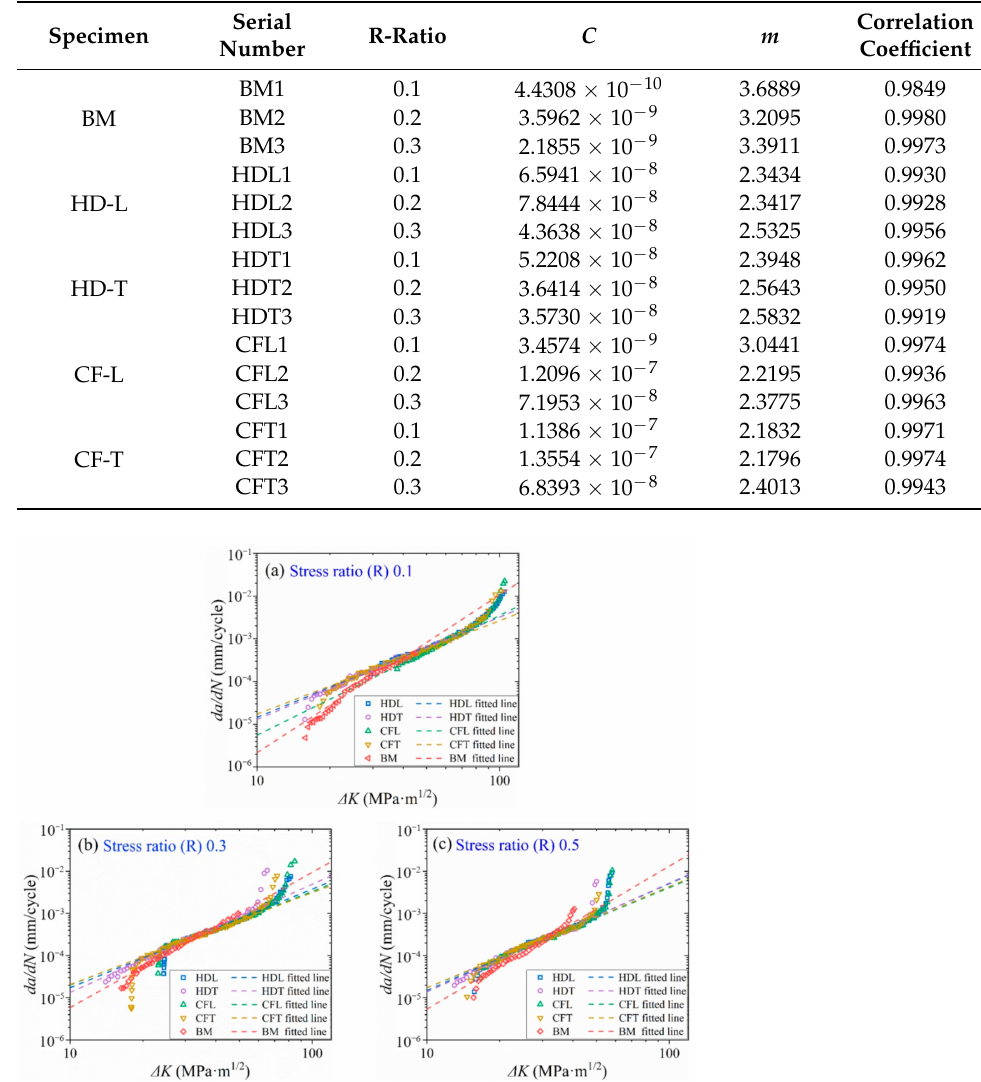
Figure 7. Comparison of FCG rates of five different specimens under the same stress ratio: ( a ) stress ratio is 0.1; ( b ) stress ratio is 0.3; ( c ) stress ratio is